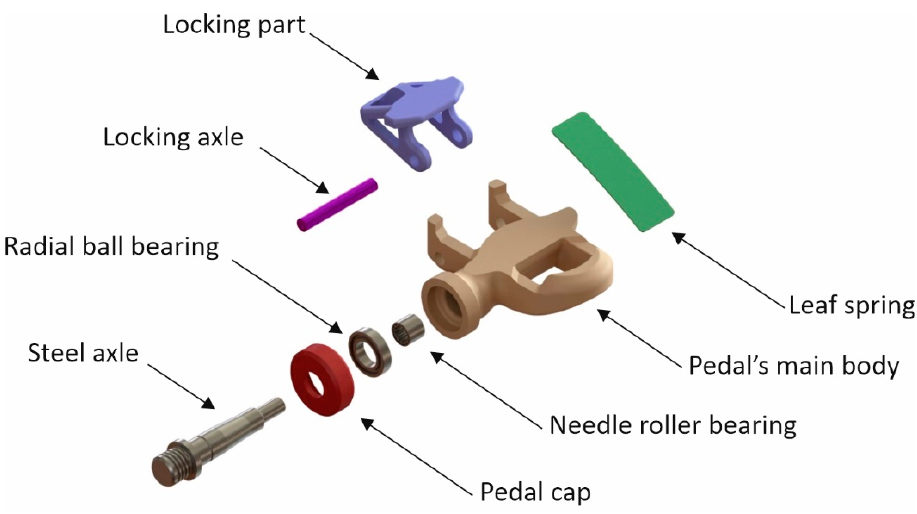
Figure 1. Proposed hybrid pedal design. ( a ) Cleat off; ( b ) cleat on.